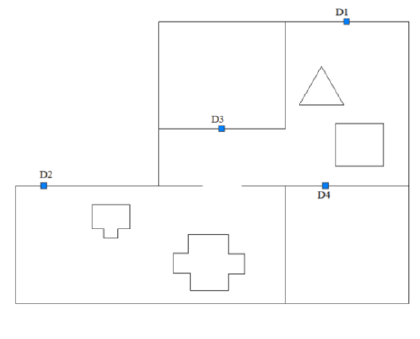
Figure 12. Simplified plan of Room C